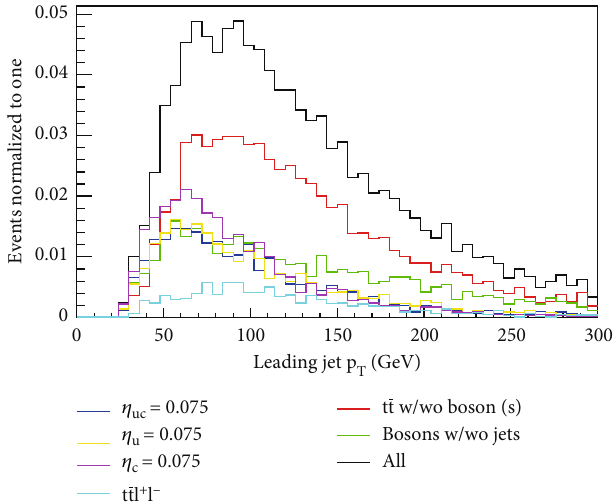
Figure 13: Jet p : even though we know our process gives mainly two b-jets, nature of process gives more jets as fi nal state objects. Higher T number of jets lowers p values for the jets coming from leading and second-leading jets and squeeze their p T jets playing role at reconstructing top quarks energetic may have p must not be